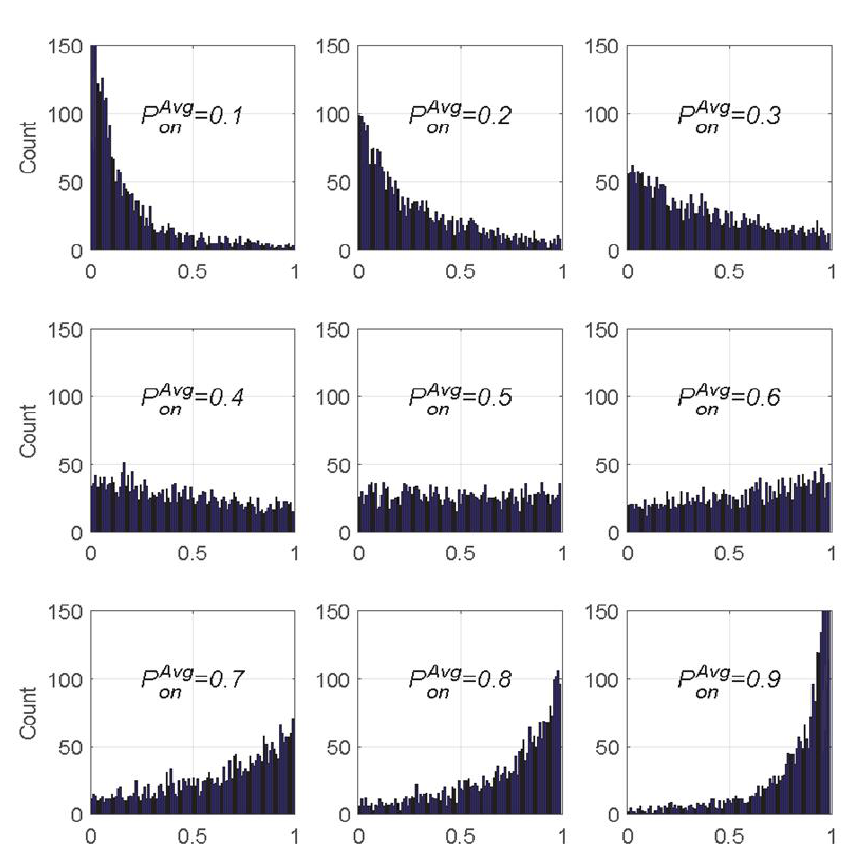
Figure 11. Results of PU traffic model generation based on the exponential probability distribution M =